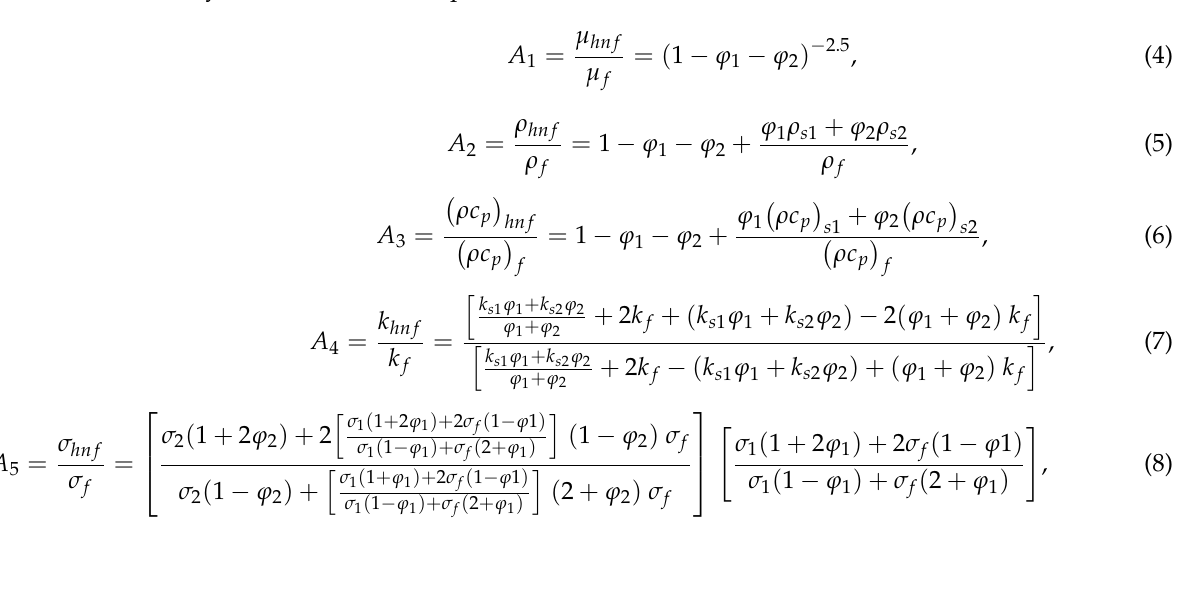
(cid:0) (cid:1) C p namely the density, dynamic viscosity, heat hnf